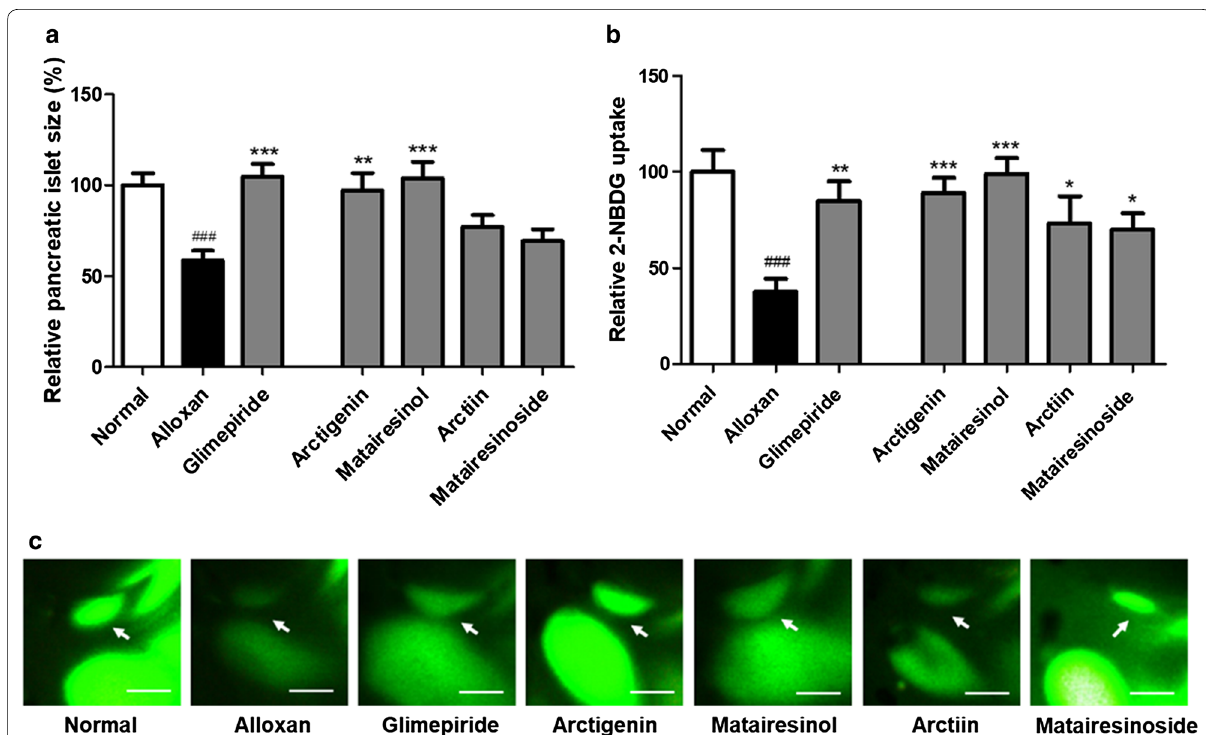
Fig. 2 Recovery effect of lignans 1–4 (10 μM) from Forsythia koreana flowers against AL‑damaged PI in ZF. a Relative size of PI of each group. b Relative 2‑NBDG uptake of PI. c PI images. Data are expressed as mean SD. ( ### p < 0.001; compared to normal), (* p < 0.05, ** p < 0.01, *** p < 0.001; ± compared to AL). Scale bar 100 =